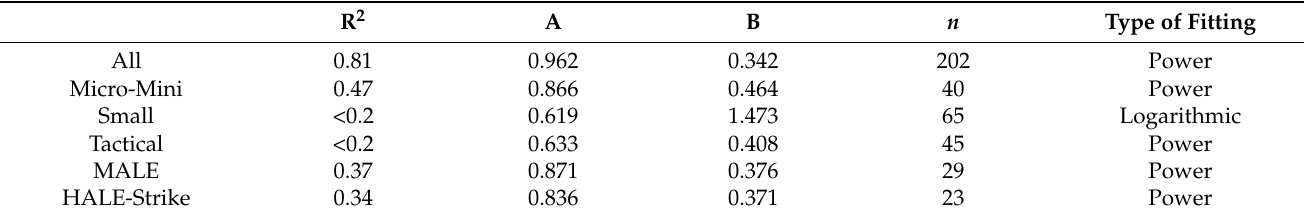
Figure 6. Wingspan as function of GTOW with respect to the NATO classification. Dark red color is used for the trendline of the entire sample, while the rest of the colors are used for the respective classes and coincide with the bullets color code, as explained in the legend. Table 5. Statistical data regarding the trend fitting for the wingspan vs. GTOW